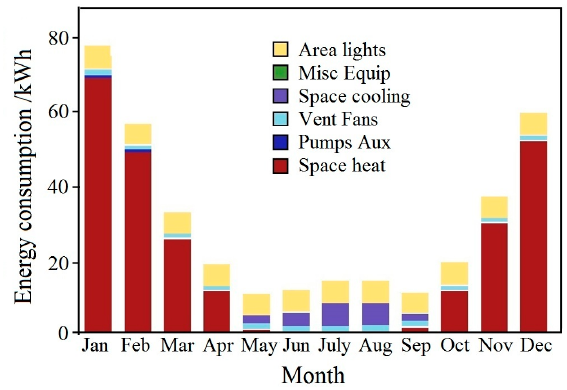
Figure 12. The energy demand percentages for (a) cooling load and (b) heating load.